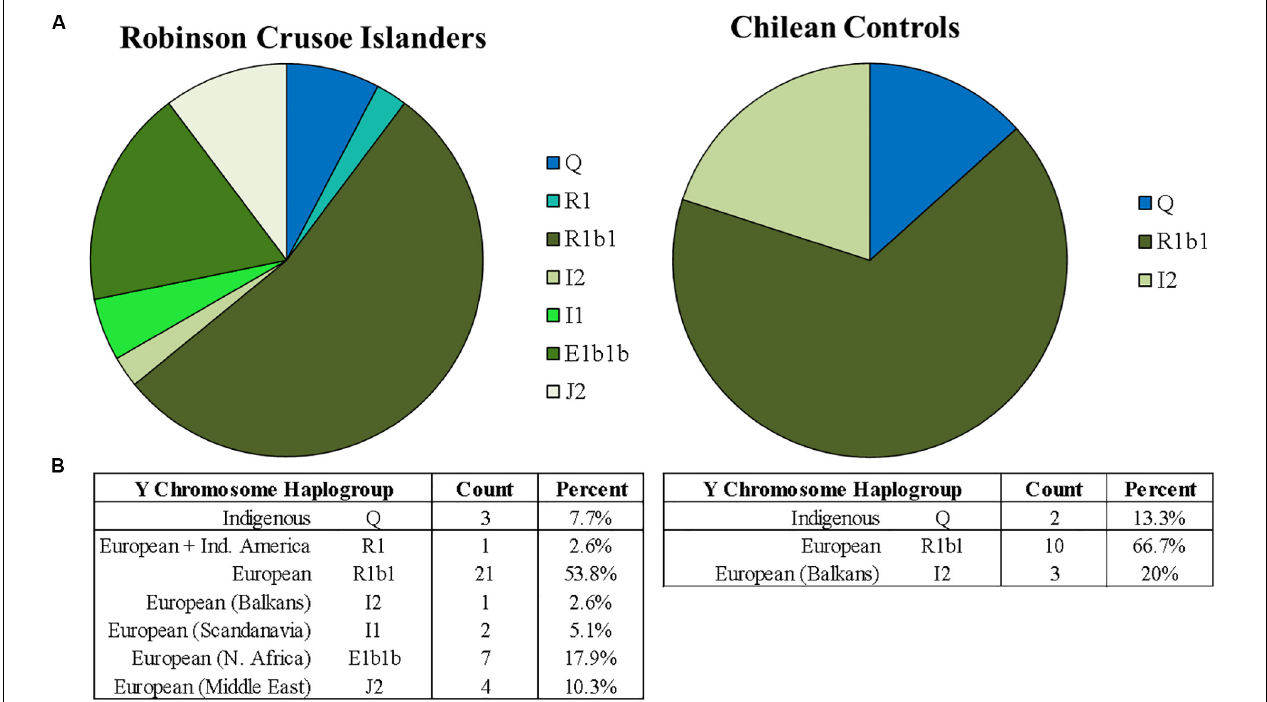
FIGURE 2 | (A) Proportions of Y chromosome haplogroups found on Robinson Crusoe Island ( N = 39) (left) compared to Chilean controls (from Santiago) ( N = 15) (right). Haplogroups origins are grouped by color: those common to South American indigenous populations (blue), and Northern Europe (green). The R1 haplogroup common to Indigenous Americans thought to be from European admixture is colored in turquoise. (B) Counts of Y chromosome haplotypes found in Robinson Crusoe Island and mainland Chilean controls grouped by Indigenous and European